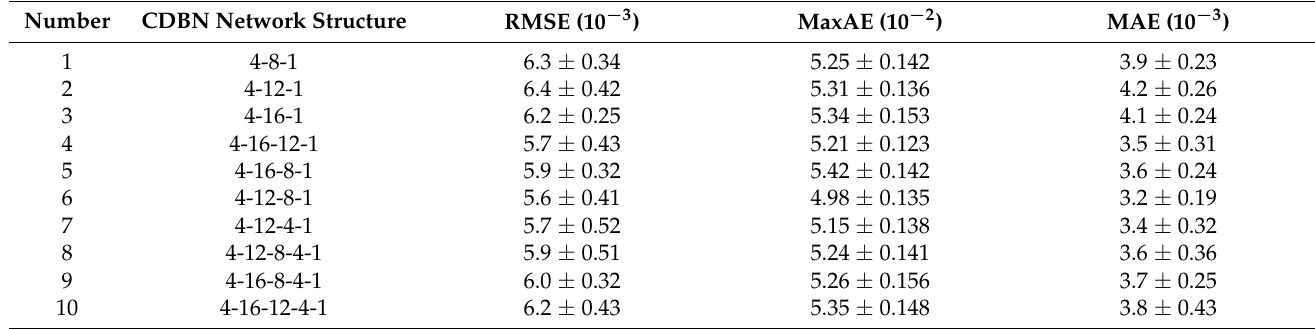
Table 5. Influence of different CDBN network structures on bearing fault